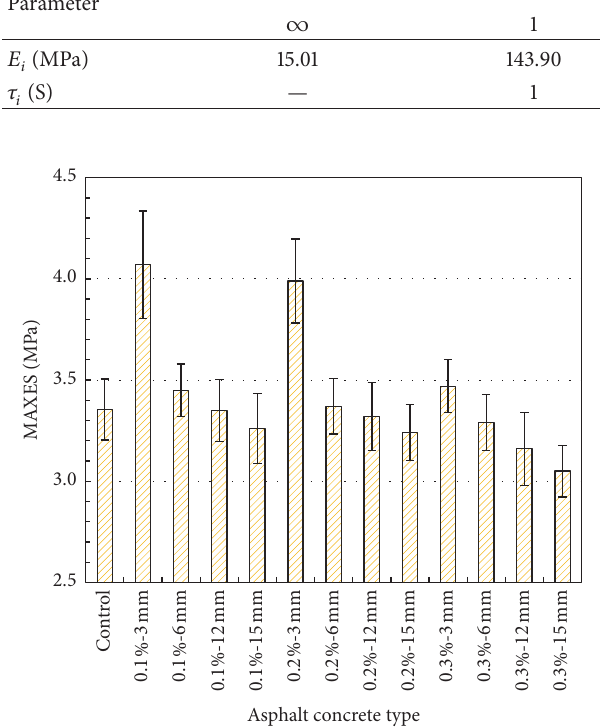
Figure 8: Maximum equivalent stress of asphalt mortar.